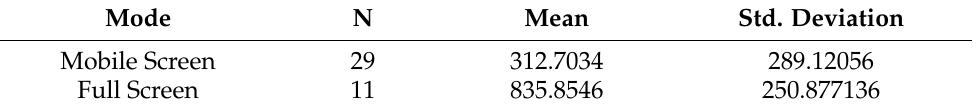
Table 2. Mean time (in seconds) spent on each page in both experimental conditions.